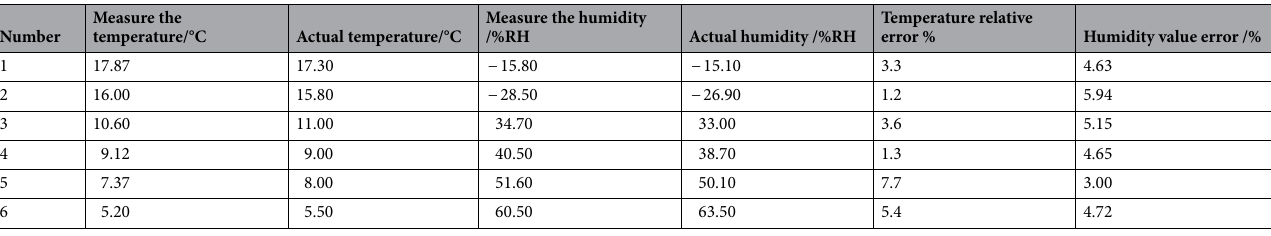
Table 7. Temperature and humidity measurement